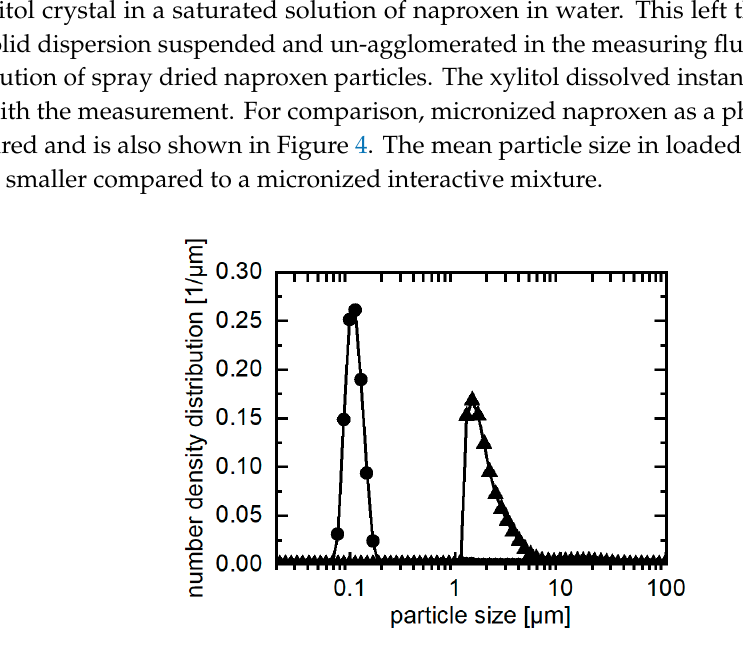
Figure 4. Particle size distributions of naproxen in xylitol processed in the melt electrostatic precipitator ( ● ) and as a physical mixture of xylitol and naproxen for reference ( ▲ ).